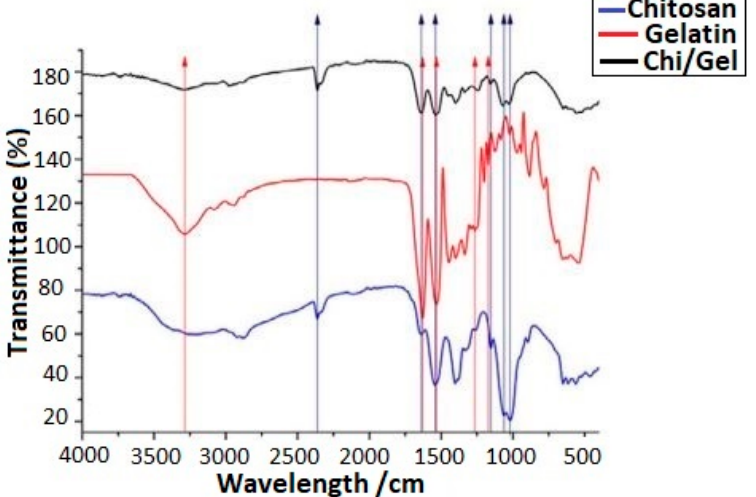
Figure 7. FTIR plot for Ag-Sr-doped MBGNs loaded in chi/gelatin coating. Reproduced from [75].